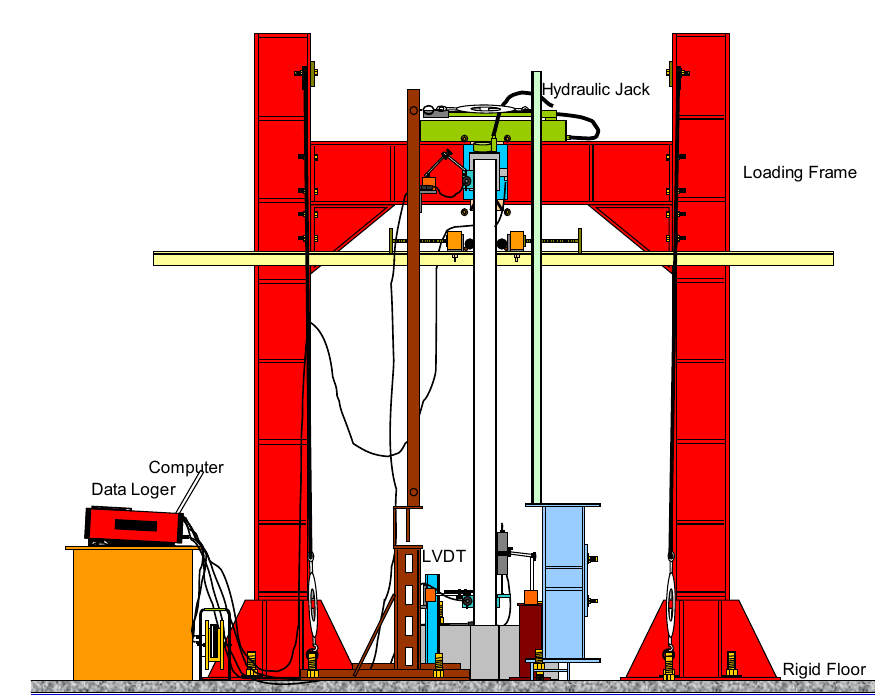
Figure 5. Test Setting.